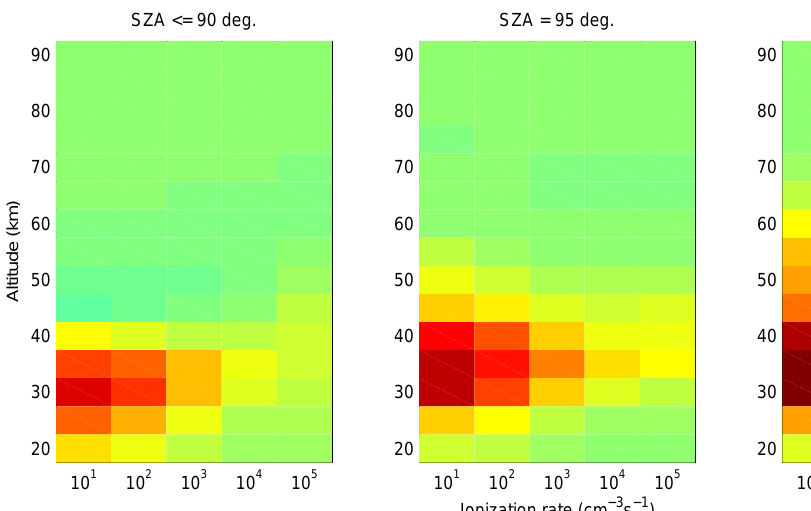
/Q for January 3